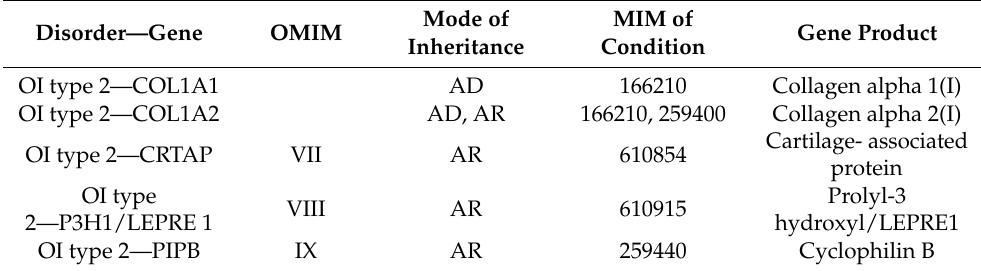
Table 7. Common variable OI with normal sclerae (OI Type 4).